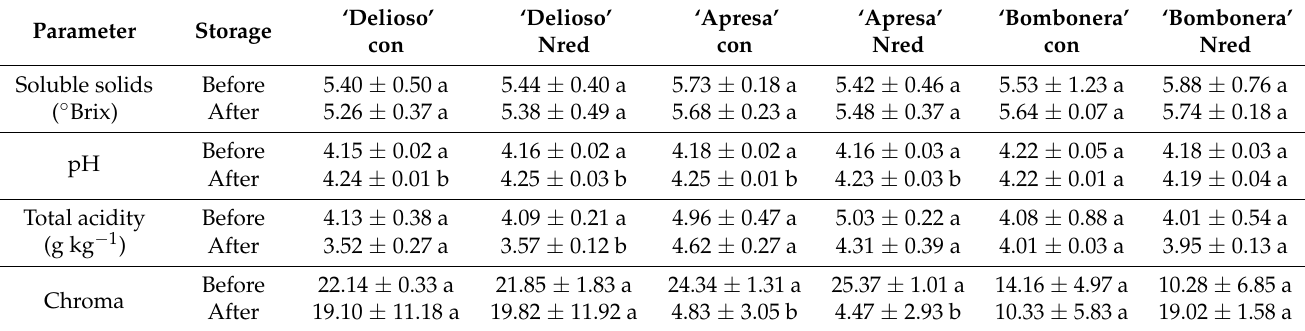
Table 6. Composition and internal color (expressed as “chroma”) of tomato fruits of three cocktail varieties grown with normal (con) and reduced (Nred) N supplies, immediately after harvest (before storage) and after 8 days of storage at 12 ◦ C (after storage). Mean of N = 3–4 ± SD. Different letters indicate significant differences due to storage within a variety and N supply(two-way ANOVA with Tukey pairwise comparison, or Kruskal–Wallis test with Mann–Whitney pairwise comparison; at α =